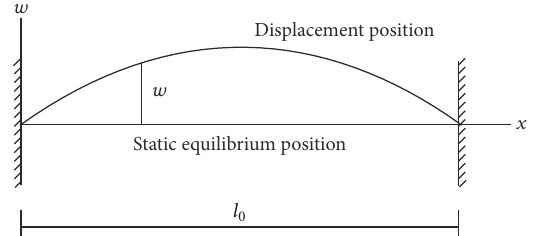
Figure 2: Displacement of the x -string component of the cross string in Figure